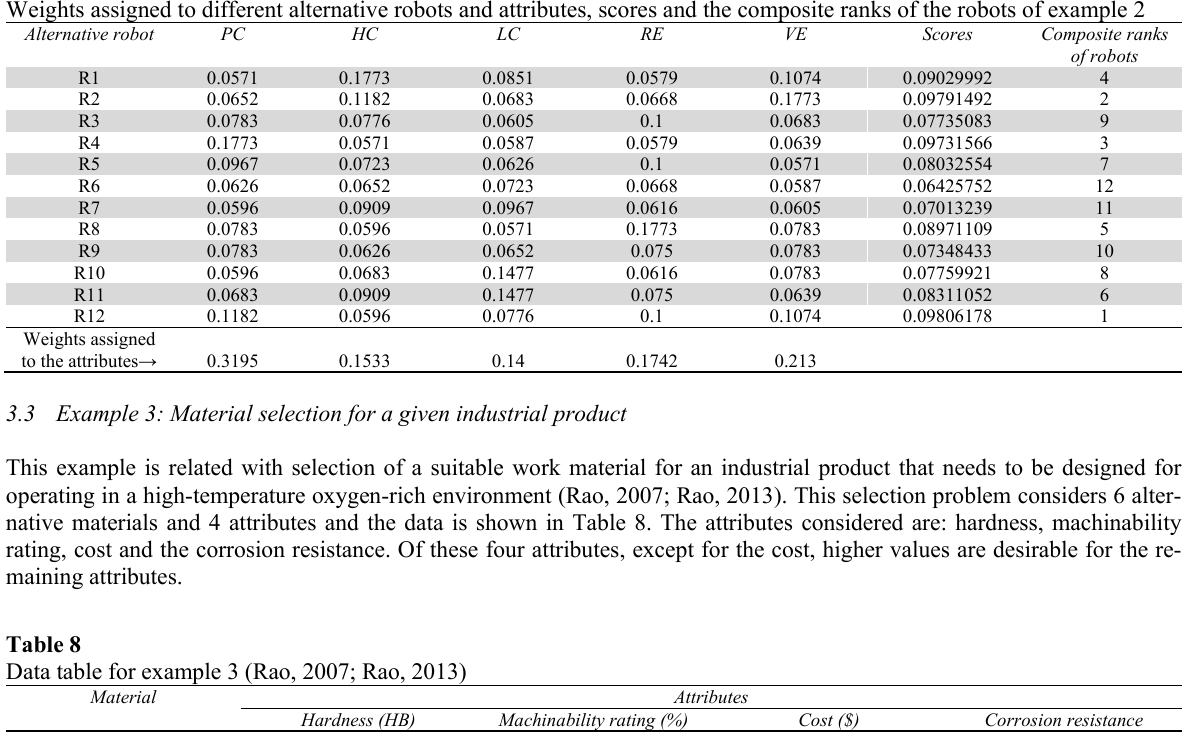
Weights assigned to different alternative robots and attributes, scores and the composite ranks of the robots of example 2 Alternative robot PC HC LC RE VE Scores Composite ranks R1